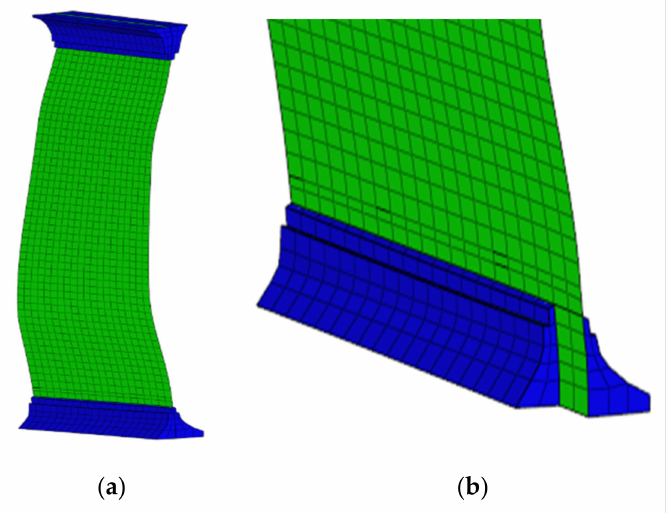
Figure 7. ( a ) Spoke 2D–3D mixed model with shell elements (green) and solid elements (blue), ( b ) focus on the transition zone, with solid elements